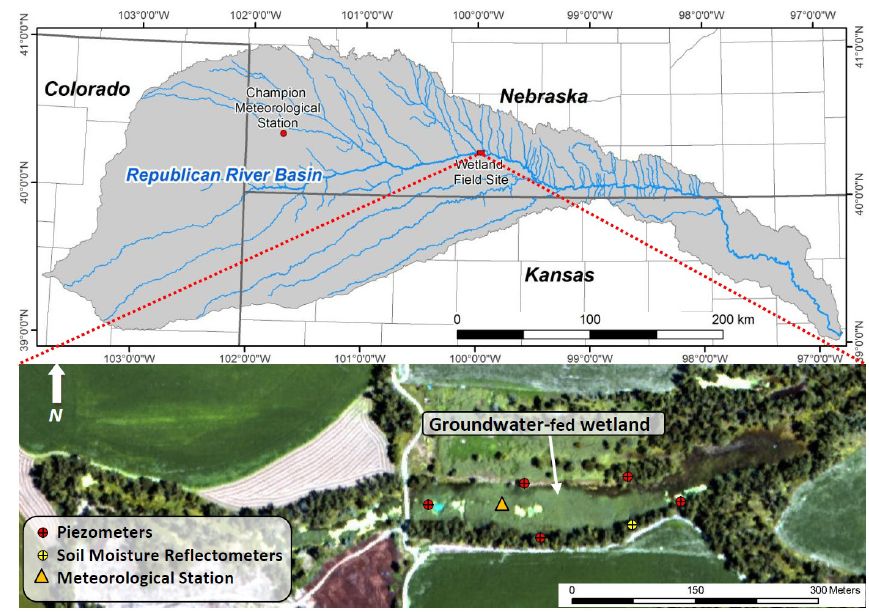
Fig. 1. Map showing the location of the piezometers, soil moisture reflectometers, and meteorological station at the wetland field site in the Republican River basin, as well as the location of the HPRCC climate station in Champion, Nebraska.